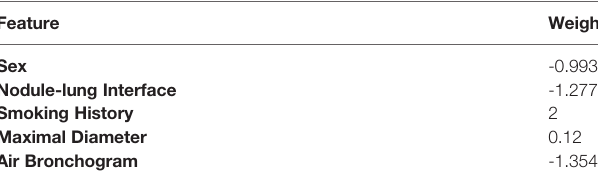
TABLE 4 | The fi ve most important features of the CFBLR model and their weights.